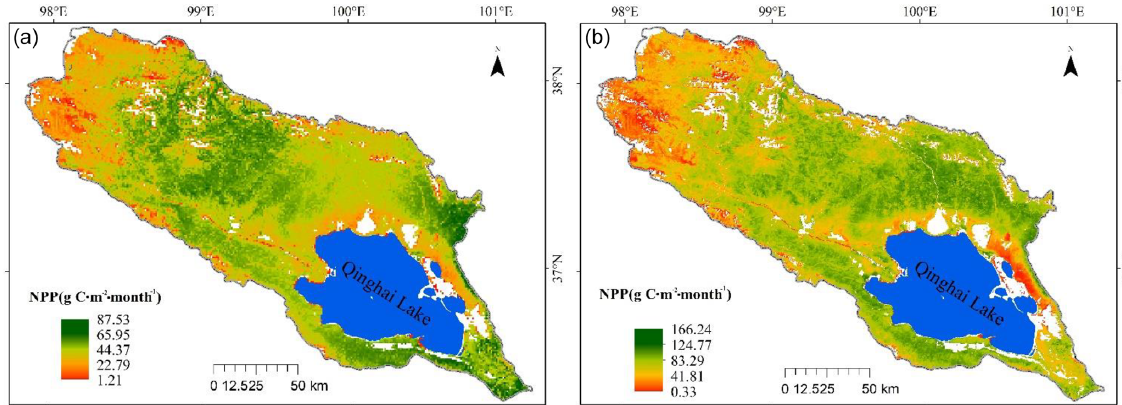
Figure 4. Spatial distribution of grassland net primary productivity (NPP) in July 2020. (a) NPP simulated by multisource-data-driven CASA. (b) NPP simulated by RS-data-driven